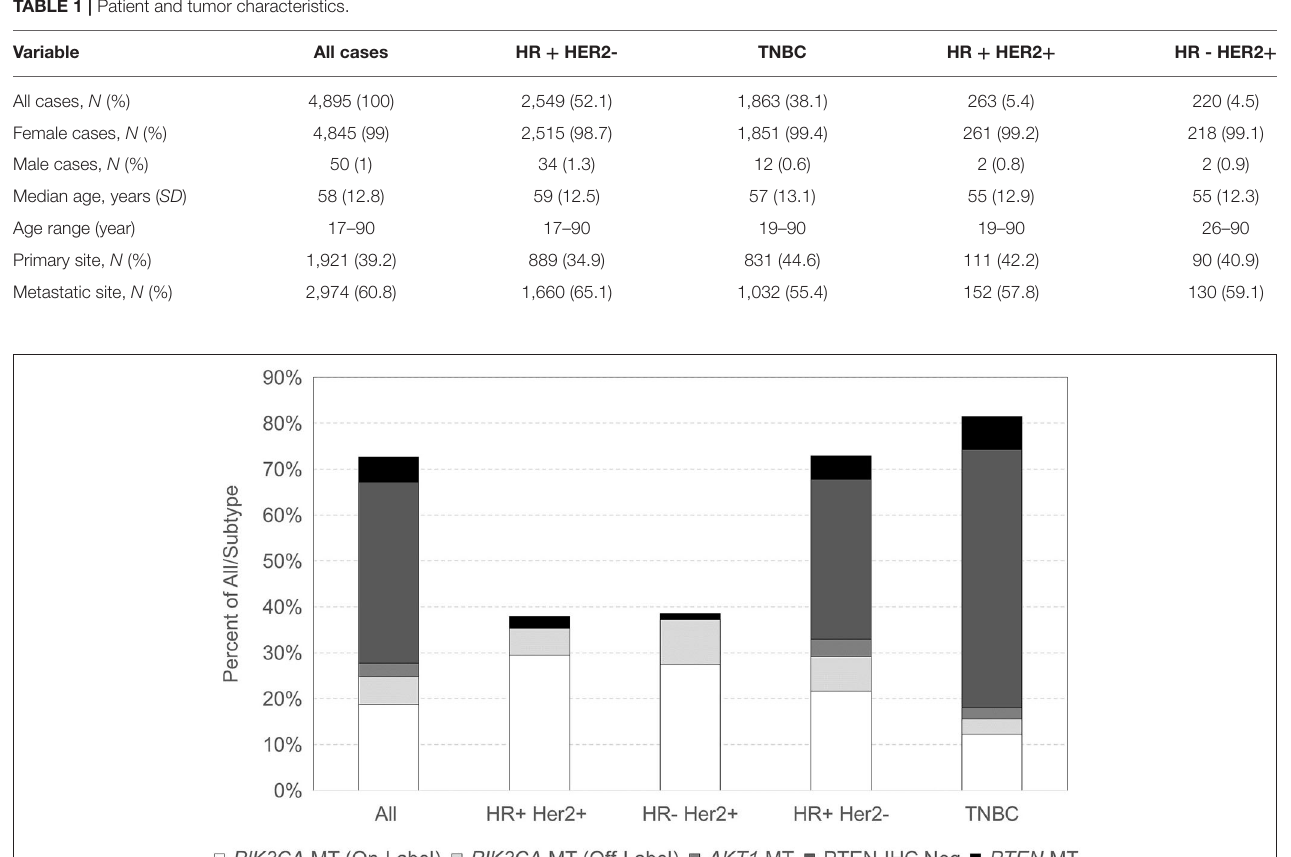
FIGURE 1 | Distribution of PIK3CA , AKT1 , and PTEN mutations across breast cancer subtypes.